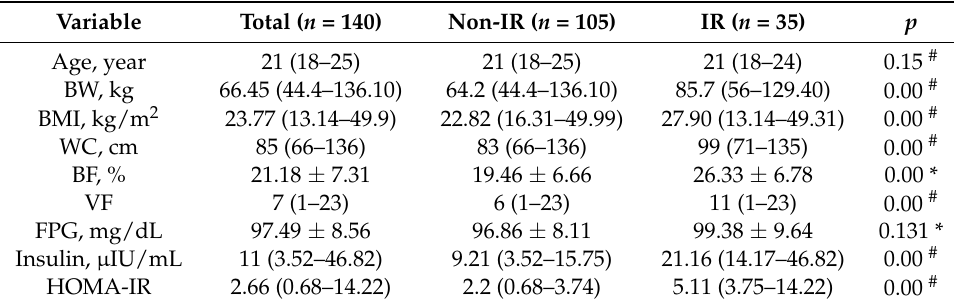
Table 1. Characteristics of Total, IR and non-IR Groups.